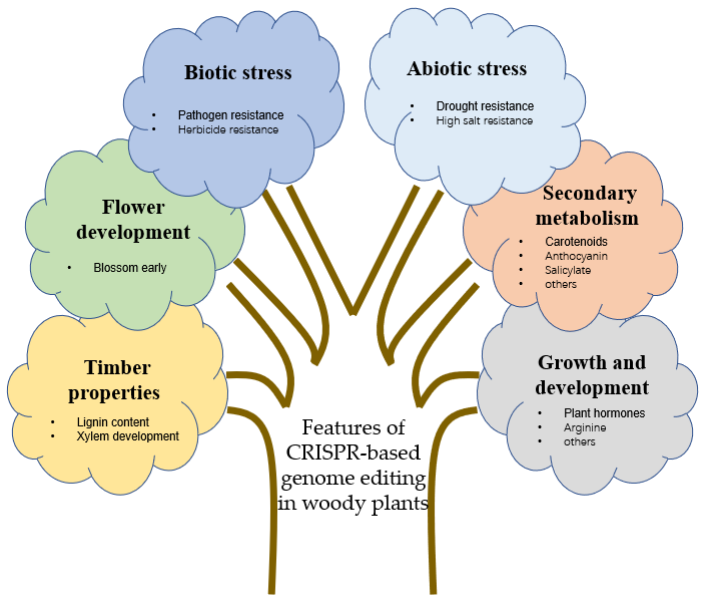
Figure 3. Features of CRISPR-based genome editing in woody plants (Provided by Microsoft PowerPoint 2019).